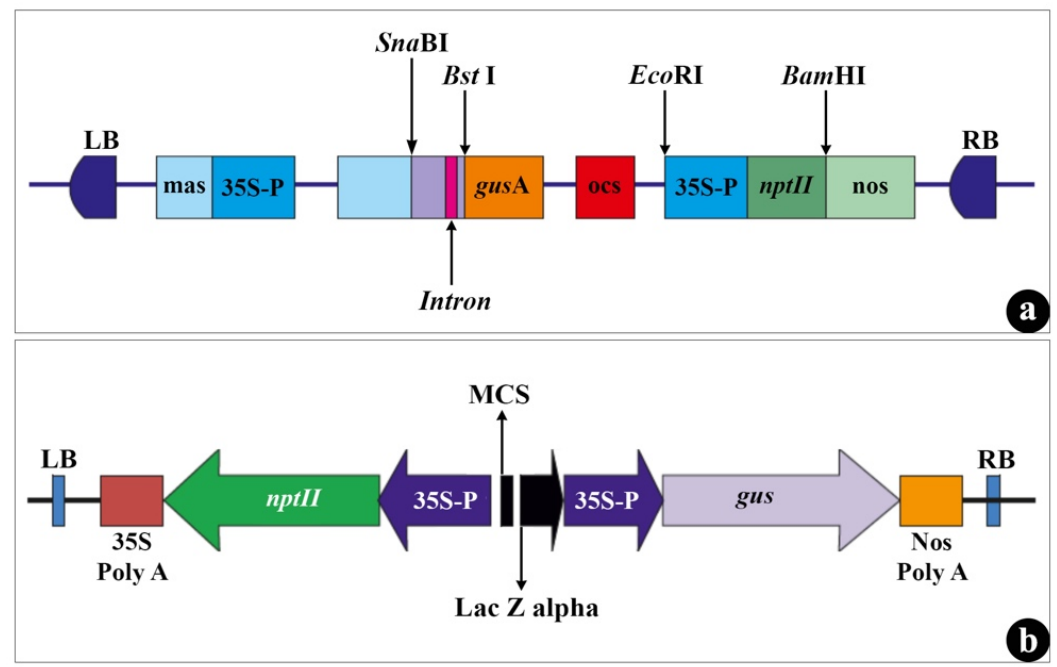
Figure 1. Genetic map of Agrobacterium tumefaciens strains ( a ) EHA 105 harboring plasmid pCNL 56, and ( b ) LBA 4404 harboring plasmid pCAMBIA 2300.